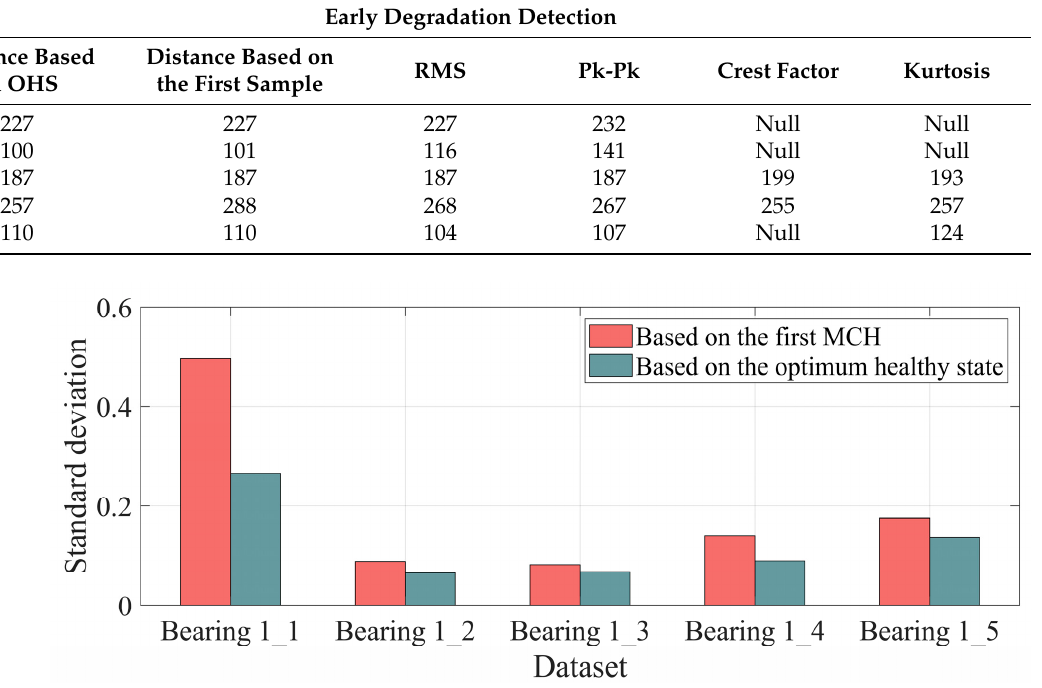
Table 4. Quantitative comparison of early degradation detection.